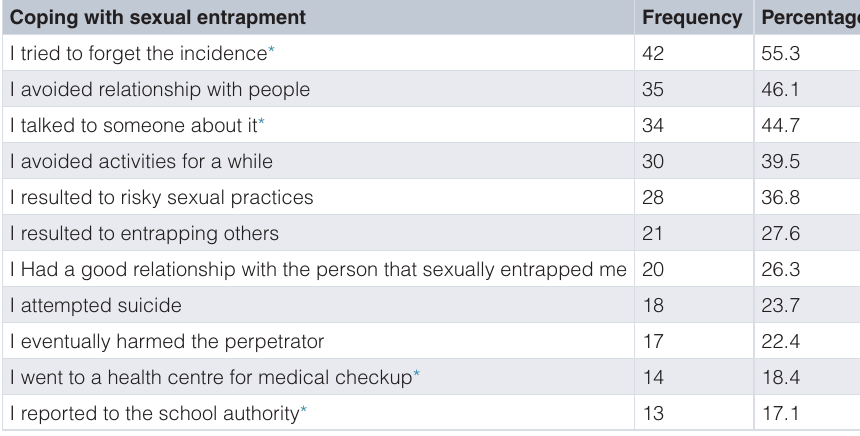
Table 6. Coping mechanism adopted after being sexually entrapped.